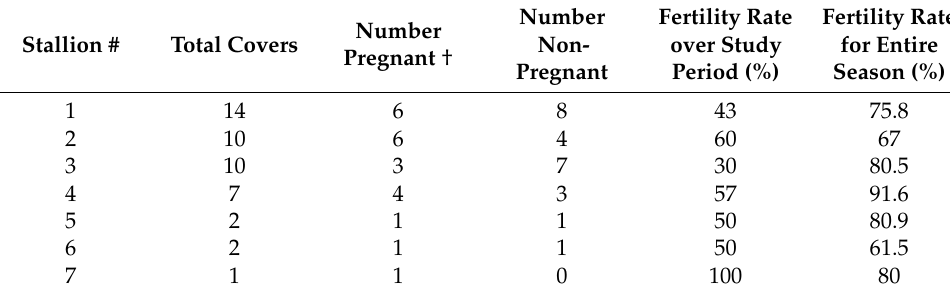
Table 1. Pregnancy rates achieved by individual